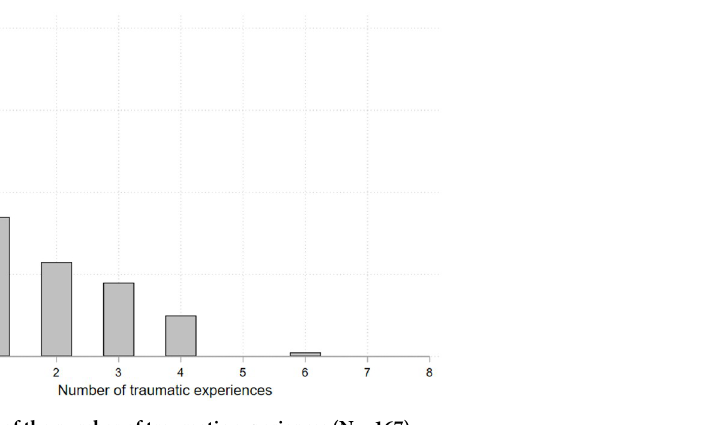
Fig 1. Distribution of the number of traumatic experiences (N = 167).